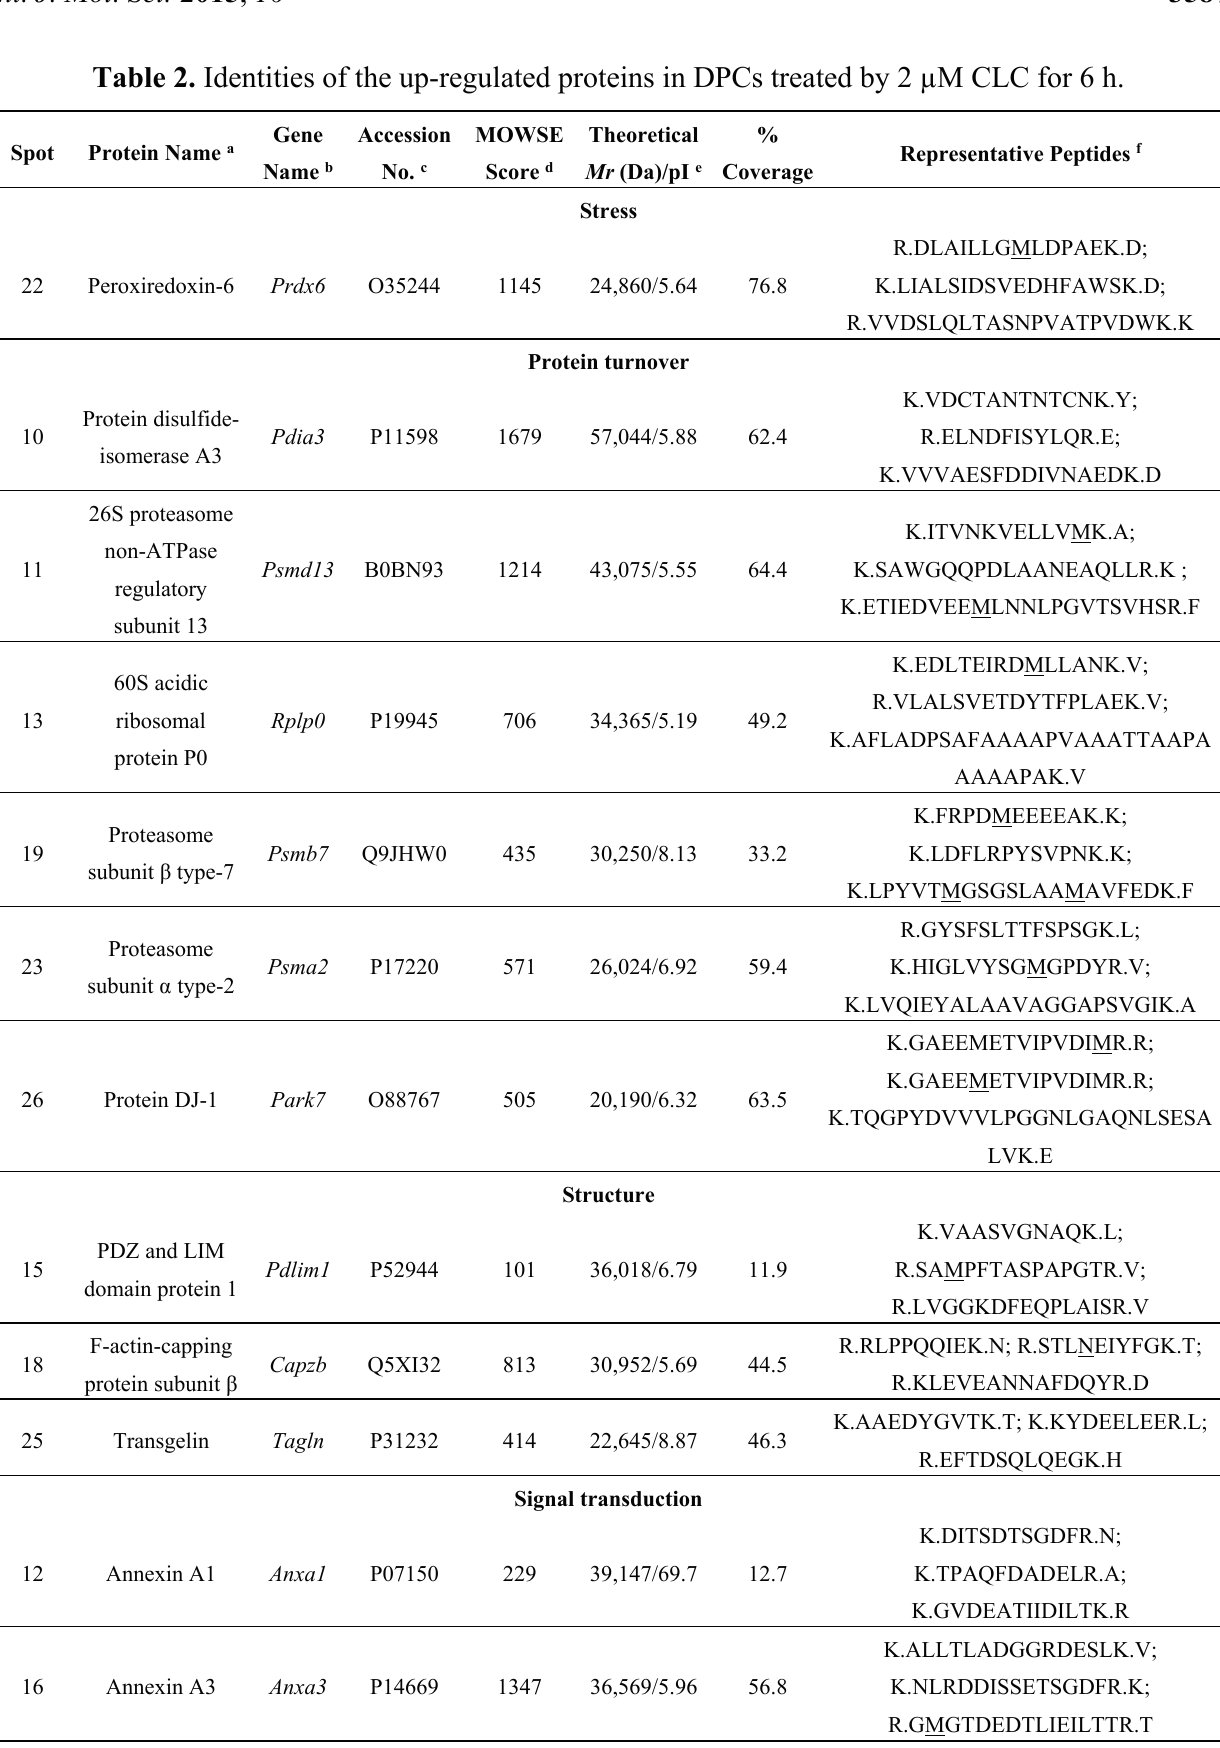
Table 2. Identities of the up-regulated proteins in DPCs treated by 2 µM CLC for 6